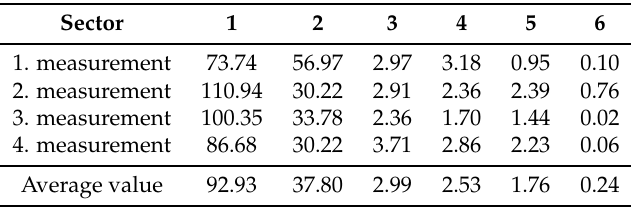
Table 1. Average values of the oil film areal density (in g/m 2 ) in a 15-mm slim pipe. The section length is 1 m. The total measured pipe length is 6 m.